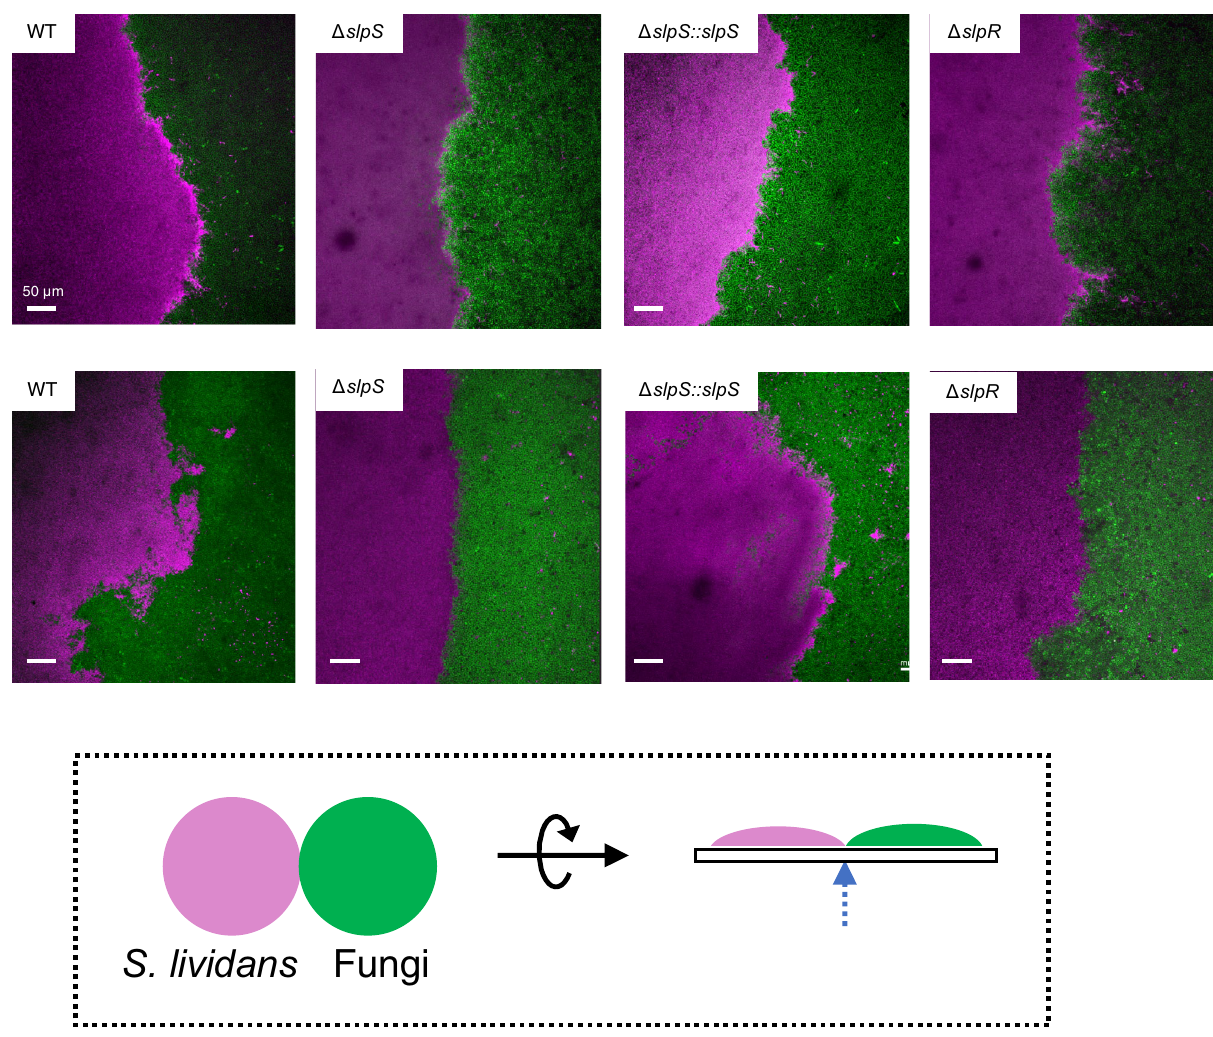
Figure 4. Confocal laser scanning microscopy (CLSM) of the colony boundaries between S. lividans and fungi. Colony boundaries between S. lividans and fungi were observed by CLSM. ( A ) S. lividans strains were co-cultured with S. pombe (top) and S. cerevisiae (bottom) on a cellophane, and the bottom of the colony boundary was then observed by CLSM. A dotted arrow in the bottom panel indicates the observed region between the colonies. S. lividans and fungi were visualized using Syto59 dye staining (magenta) and GFP expression (green), respectively. Scale bars, 50